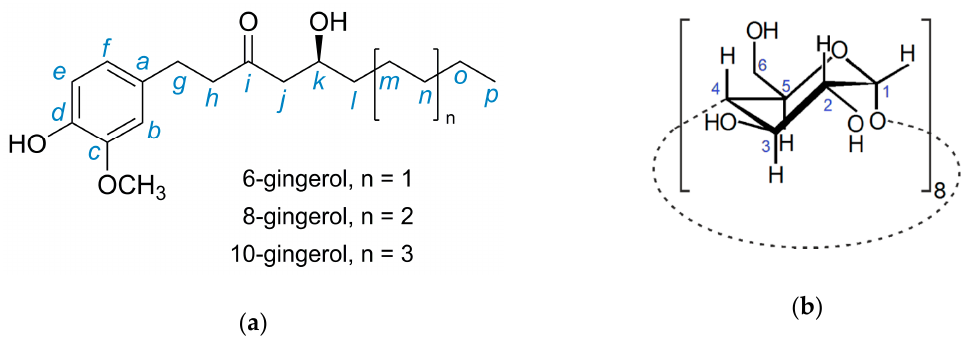
Figure 1. Schematic representation of ( a ) 6-, 8-, and 10-gingerols, the components of the mixture used